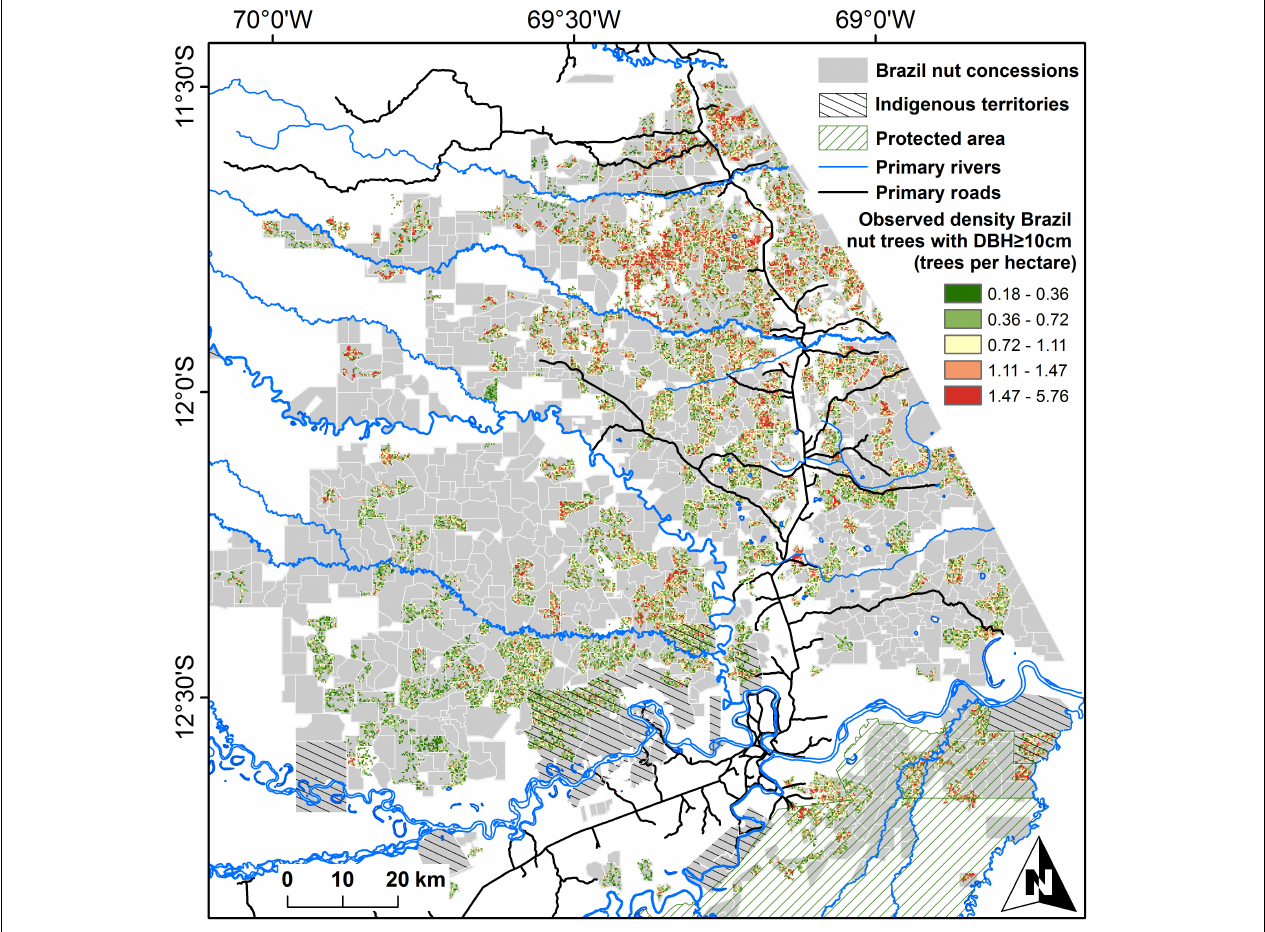
FIGURE 3 | Distribution of Brazil nut concessions in Madre de Dios, Peru. Brazil nut tree densities [diameter at breast height (DBH) ≥ 10 cm] in concessions considered in this paper are presented as average numbers of trees per hectare, calculated from projections of single trees on 7.5-arc-second grid cells. Gray areas in sampled concessions had zero